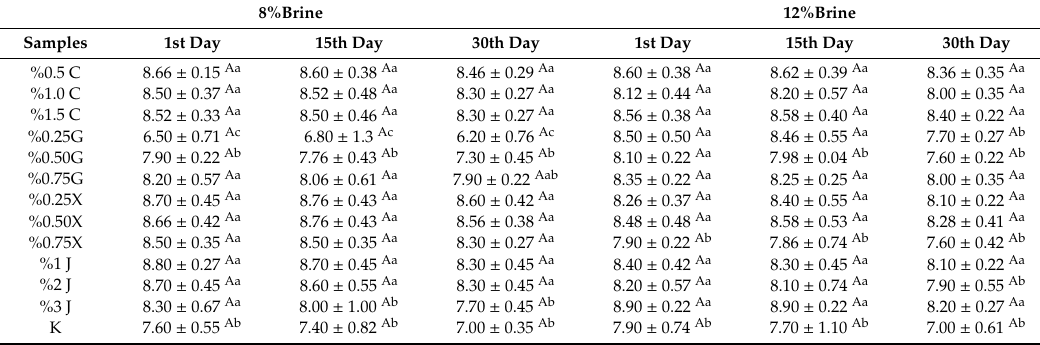
Table 16. General acceptance score of cheese samples during